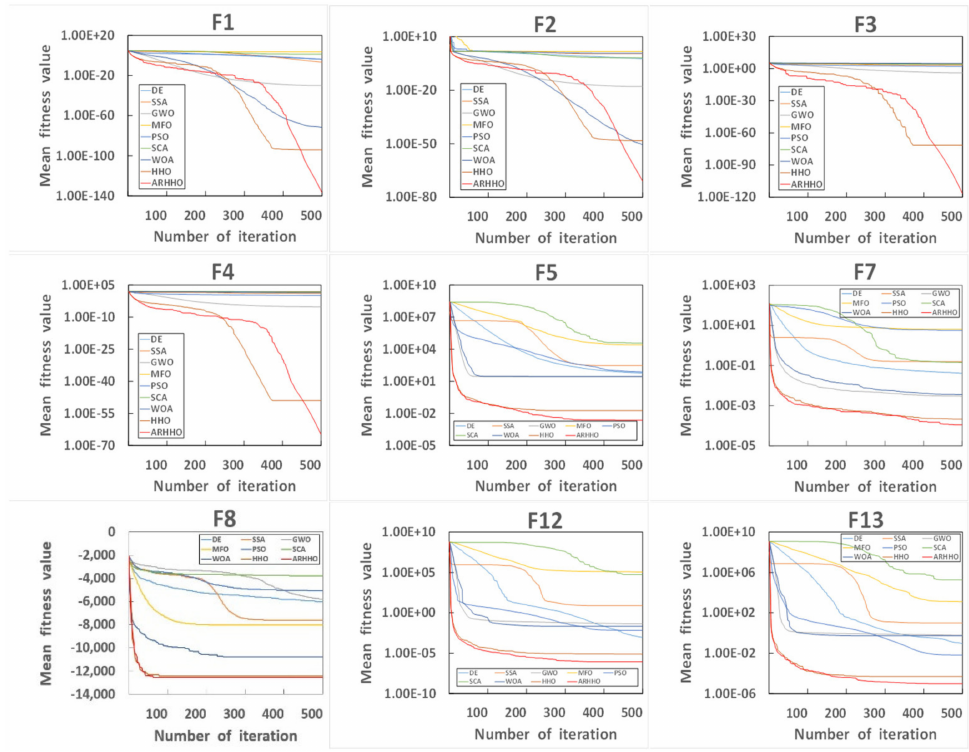
Figure 6. Convergence curves of the benchmark